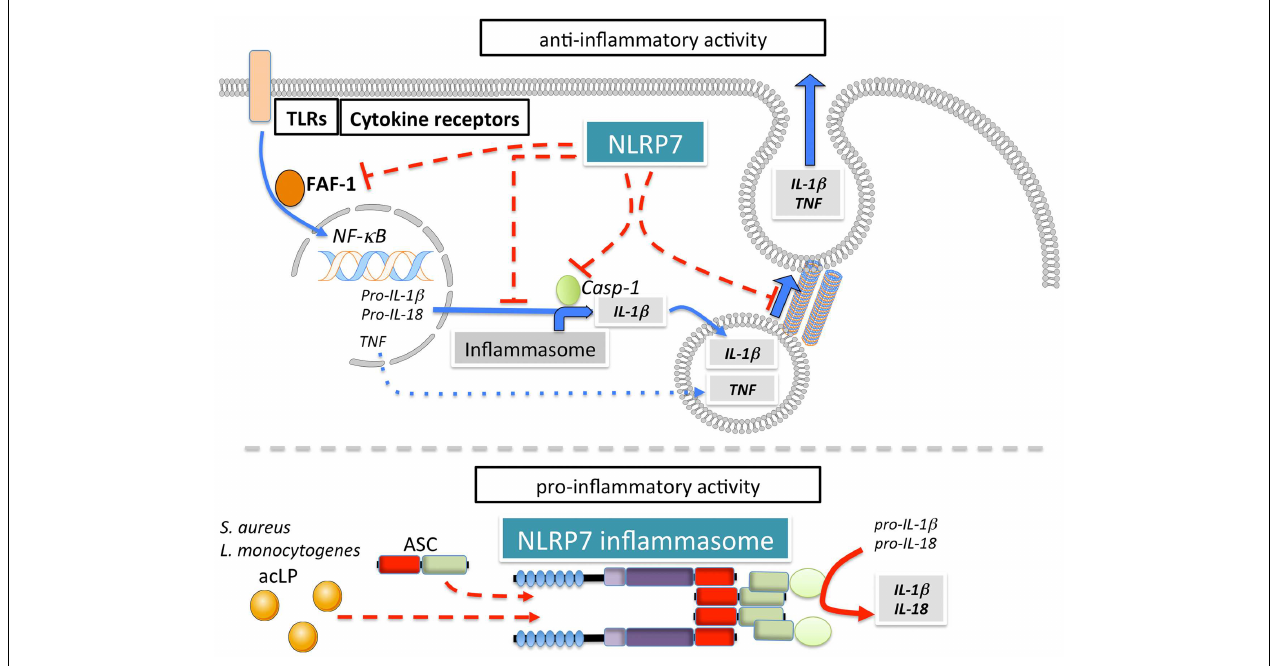
FIGURE 6 | Pro- and anti-inflammatory mechanisms of NLRP7